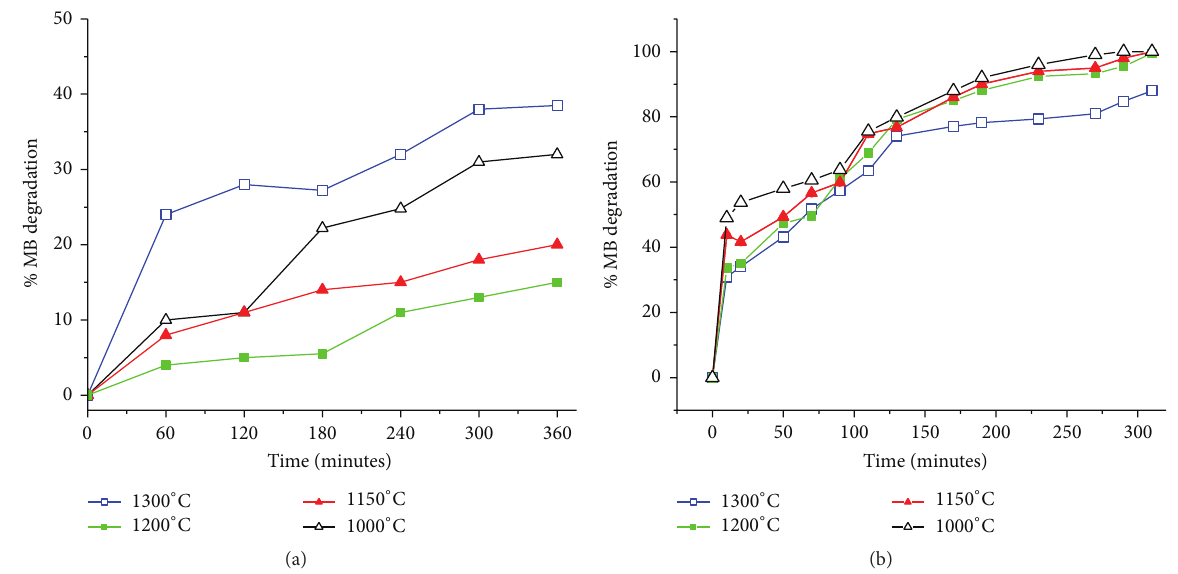
Figure 7: Degradation curves of MB: (a) under UV light at 365 nm and (b) under solar irradiation.